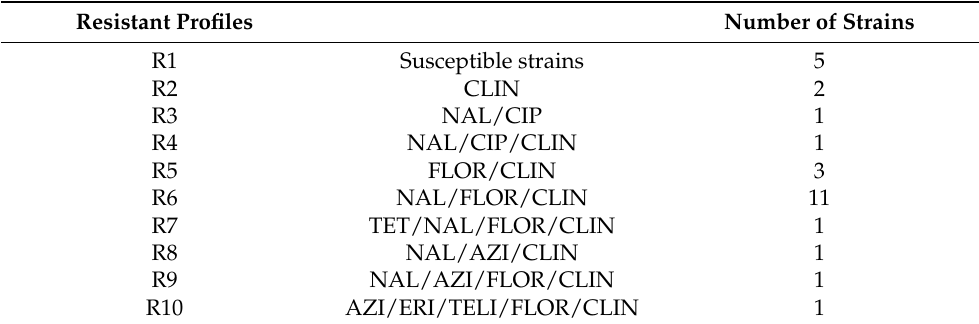
Table 1. Resistance profiles of 27 strains of Aliarcobacter butzleri isolated from commercial poultry meat from S ã o Paulo city, Brazil.